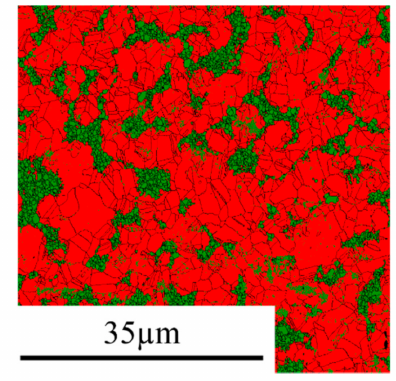
Figure 1. EBSD phase map of the Ni-50W alloy; the Ni(W) solid solution and W clusters appear in red and in green, respectively. (For interpretation of the references to color in this figure legend, the reader is referred to the web version of the article [7]).